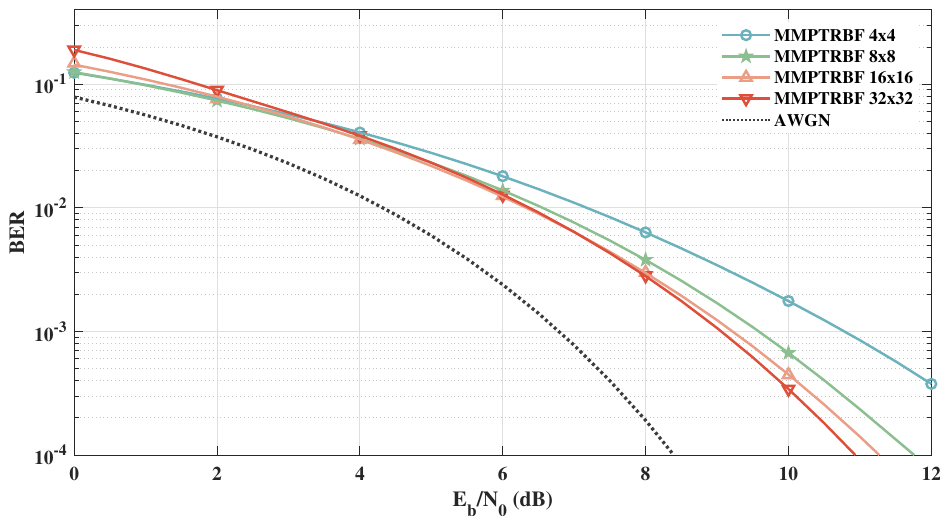
Figure 20. MMPTRBF with M T = M R = 4, M T = M R = 8, M T = M R = 16, M T = M R = 32, antennas for 4-QAM modulation.